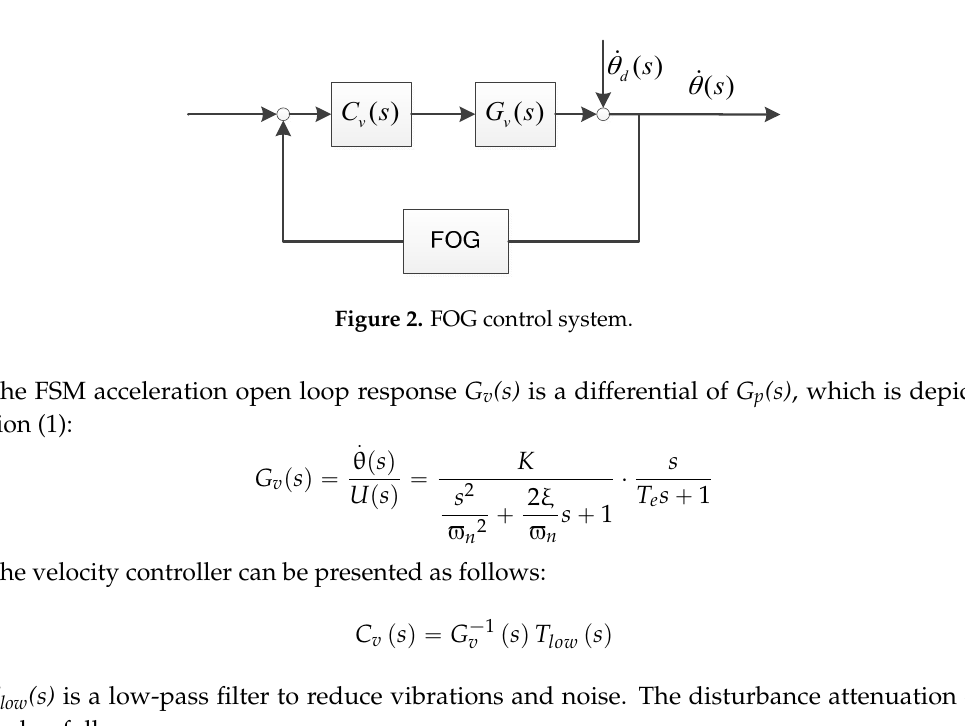
Figure 2. FOG control system.